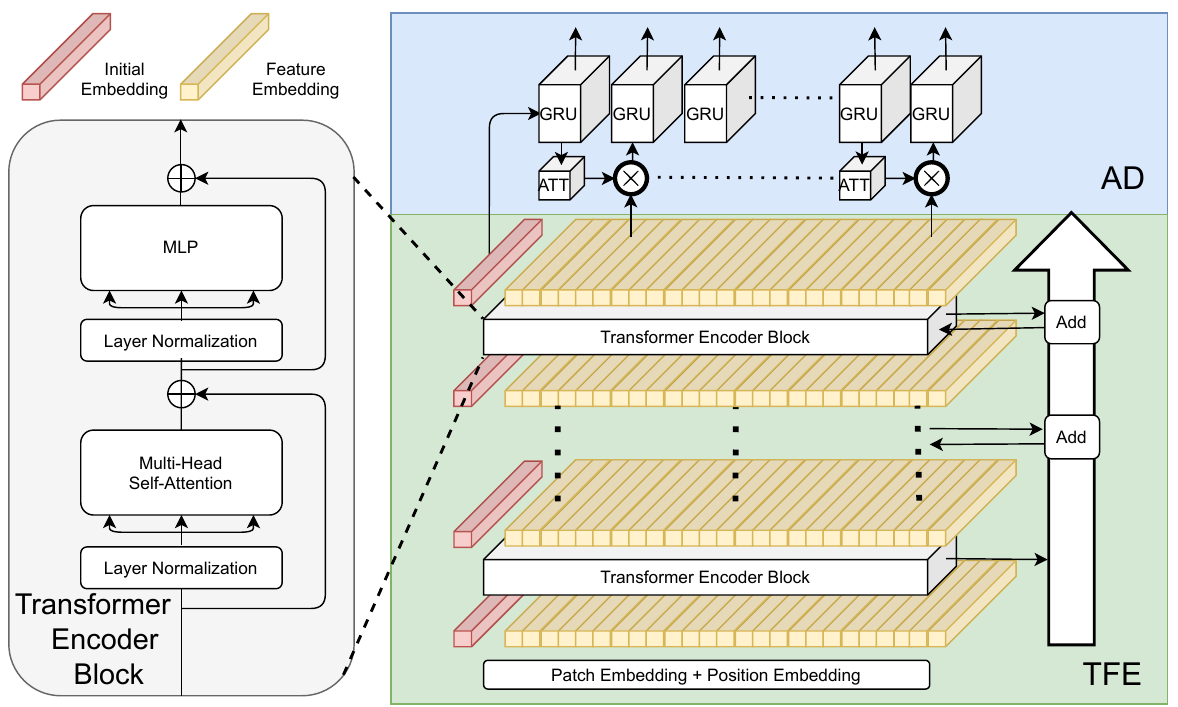
Figure 3. The detailed architectures of the TFE and AD module. TFE consists of Patch Embedding, Position Embedding, Transformer Encoder Blocks, and Residual add module. The skip edge in the Residual add module connects Multi-Head Self-Attention modules in adjacent Transformer Encoder Blocks. Here, ⊗ denotes matrix multiplication, ⊕ denotes broadcast element-wise